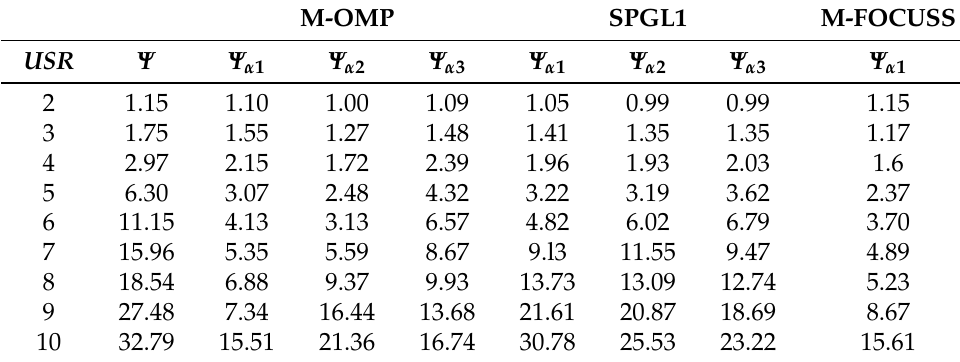
Table 11. Comparison of PRD values from the algorithms using the three dictionary matrices at several USR values, for ECG signal no. 113.